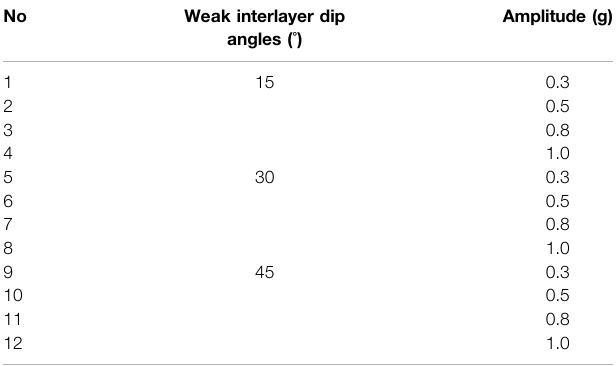
TABLE 1 | Calculation conditions in numerical simulation. No Weak interlayer dip angles ( °